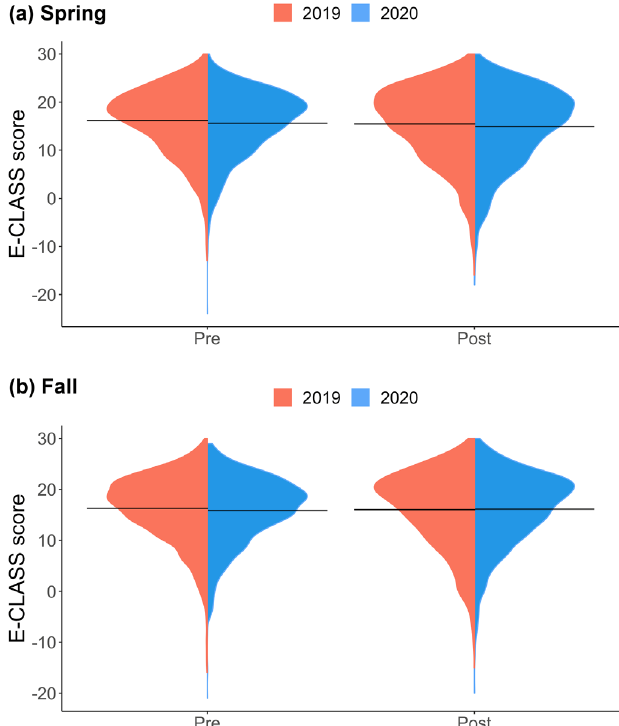
FIG. 1. Violin plots showing the distribution of pretest (left plot) and post-test (right plot) E-CLASS scores for all courses that occurred in (a) Spring 2019 and Spring 2020, and (b) Fall 2019 and Fall 2020. Horizontal black lines indicate the mean score for each